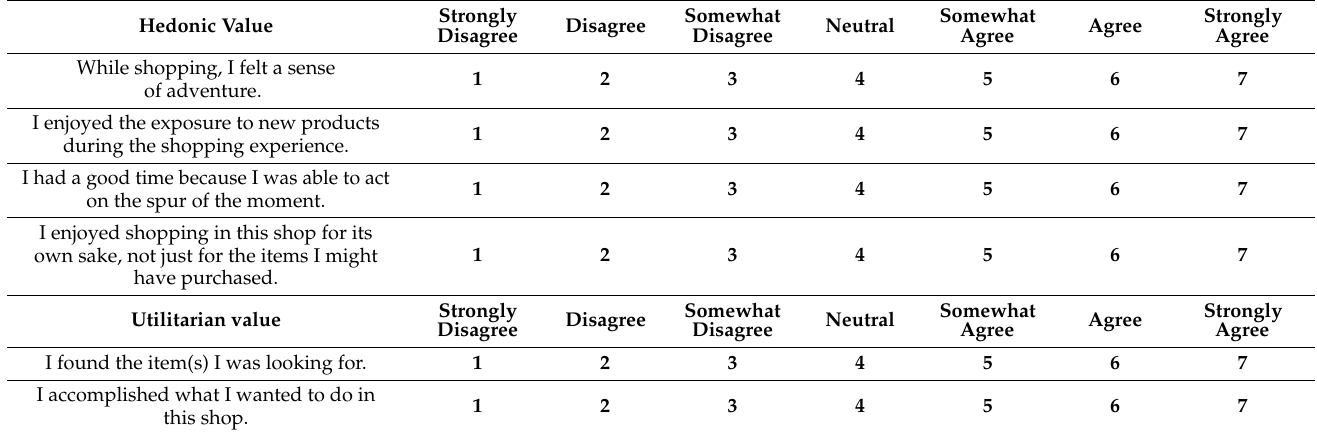
Table A2. Please provide responses to the following questions with regard to perceived value.